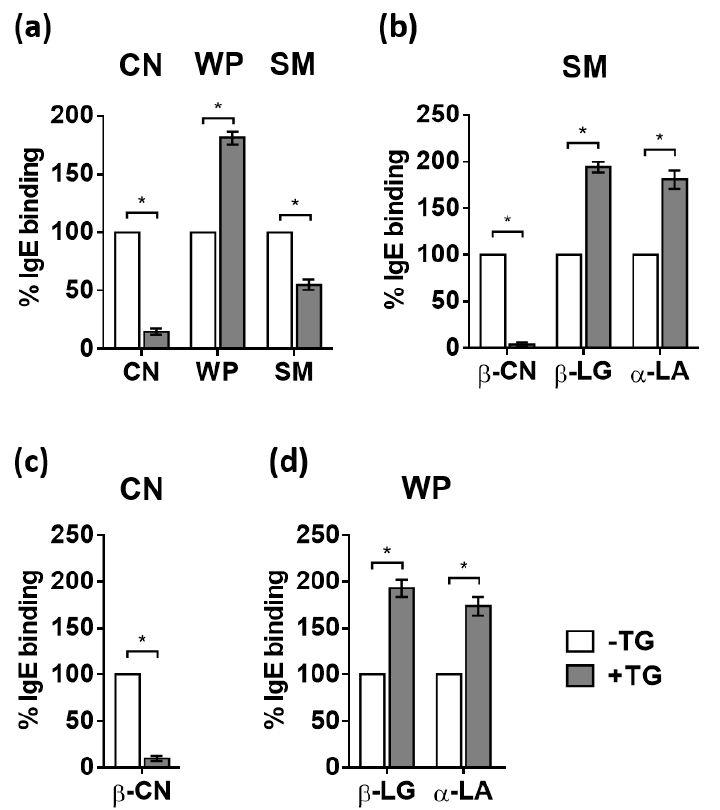
Figure 2. IgE binding to casein (CN), whey proteins (WP) and skim milk (SM), either untreated ( − TG, white bars) or treated with transglutaminase (+ TG, grey bars), estimated by inhibition ELISA with sera from milk allergic patients (Table 1). ( a ) IgE binding to CN, WP, and SM, ( b ) specific IgE binding to β -casein ( β -CN), β -lactoglobulin ( β -LG), and α -lactalbumin ( α -LA) in SM; ( c ) specific IgE binding to β -CN in CN, and ( d ) specific IgE binding to β -LG and α -LA in WP. The proteins used for pre-coating the plates are indicated on the x-axes. Data are expressed as means ± SEM of 3 different experiments. Statistically significant differences ( p < 0.05) are indicated by asterisks.